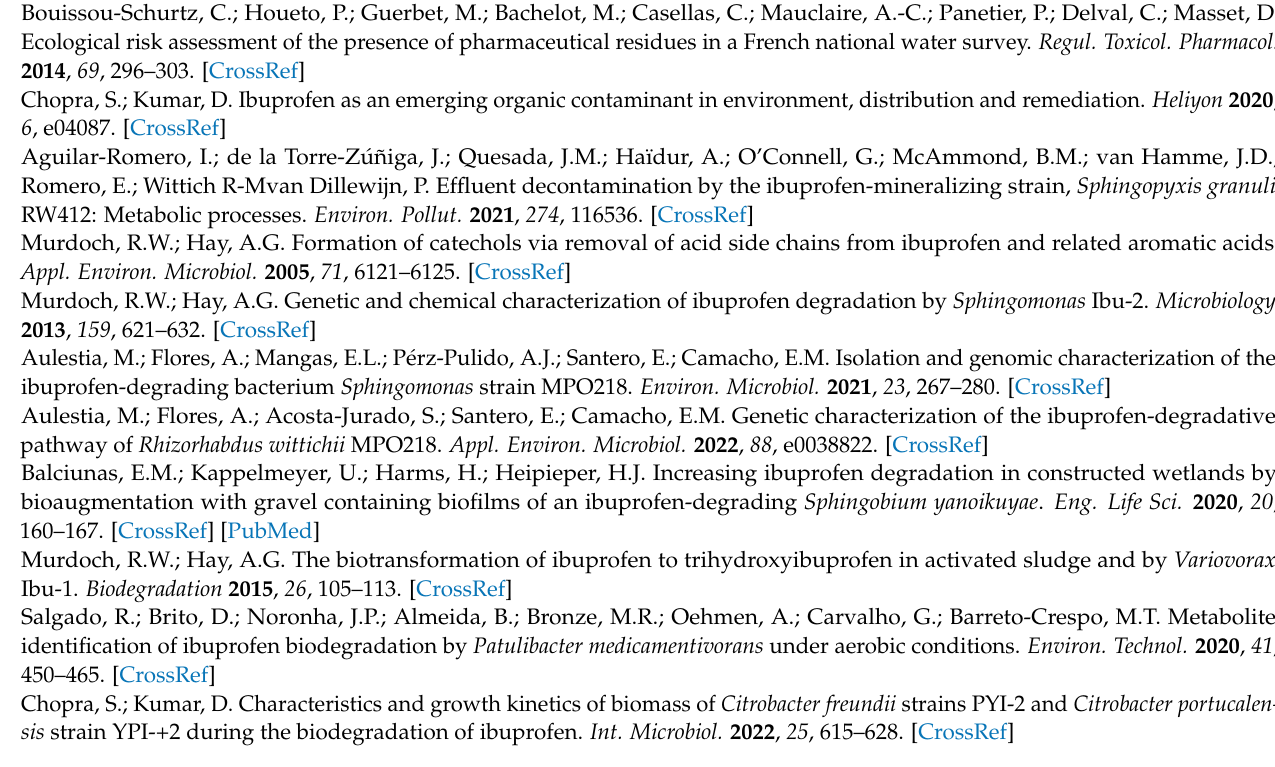
Table S1: Primer list; Table S2: PCR